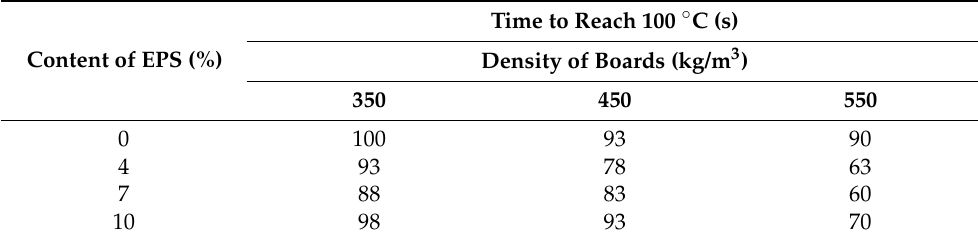
Table 2. Time needed for the core layer of mat to reach 100 ◦